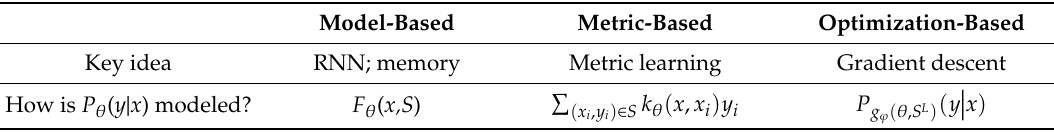
Table 1. Meta-learning